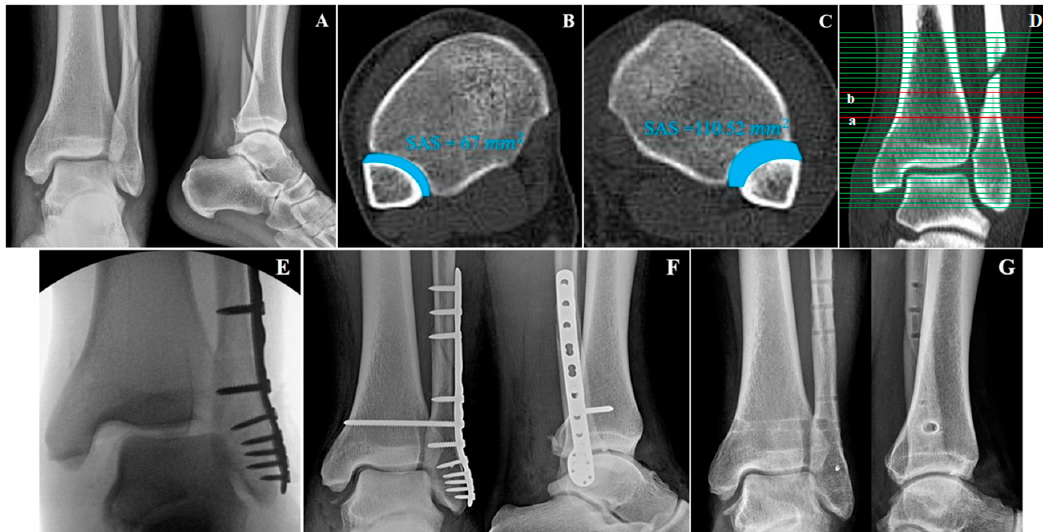
Figure 1. Thirty-seven-year-old male with left ankle fracture. Preoperative anterior-posterior (AP) and lateral radiographs ( A ). Bilateral axial computed tomography (CT) scan of intact ( B ) and injured ankle ( C ) with surface area of syndesmosis (SAS) measured. The ratio of his SAS (injured/intact) was 1.65. Corresponding coronal section ( D ) at level of 1.0 cm ( a ) and 1.5 cm ( b ) above the tibial plafond. Intraoperative fluoroscopic image ( E ) during stress test demonstrates possible syndesmotic injury. Immediate postoperative AP and lateral radiographs with syndesmosis transfixation included. ( F ) Last follow up of AP and lateral radiographs ( G ) with implanted devices removed without diastasis recurrence 11 months later.